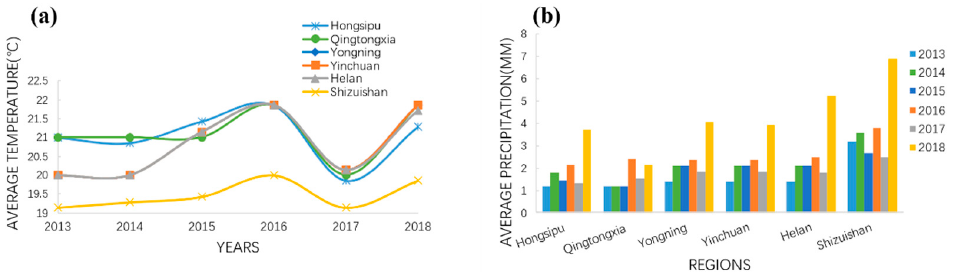
Figure 2. Average temperature ( a ) and precipitation ( b ) records from March to September 2013–2018 in the six sub-regions of Ningxia.